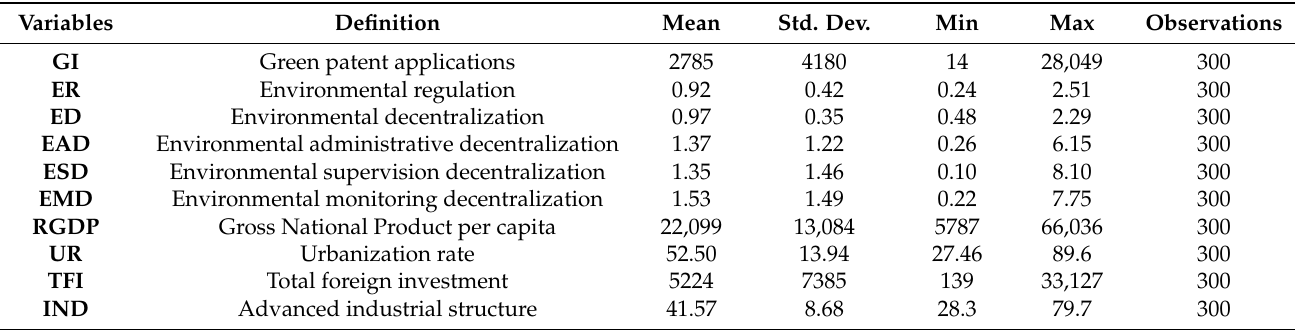
Table 1. Descriptive statistics for key